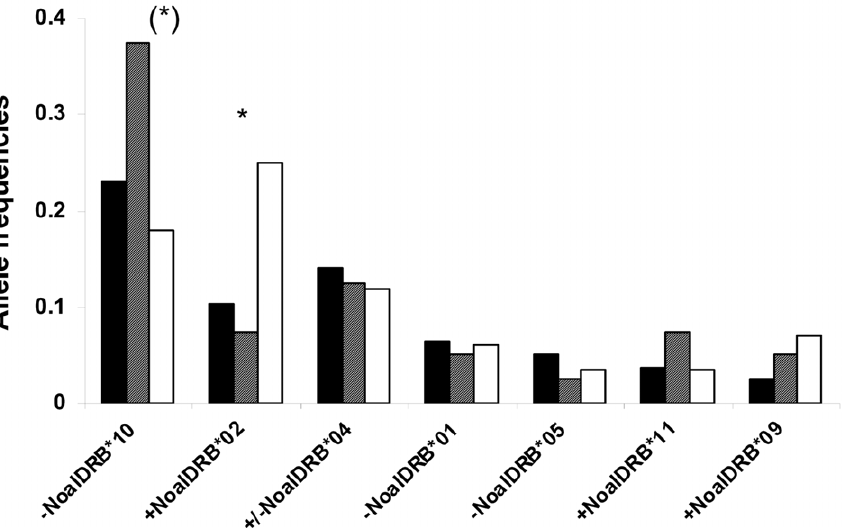
Figure 1. Allele frequencies of MHC class II DRB exon 2 influencing the ectoparasite infestation in N.albiventris . Distribution of Noal- DRB alleles influencing the ticks and bat flies infestation in reproductive males (black bars), subadults (grey bars) and non-reproductive males (white bars). ‘ + ’ indicates an association with an increased and ‘ 2 ’ with a decreased parasite load. Allele Noal-DRB *02 is significant accumulated in non- reproductive males and less frequent in subadults ( x 2 =10.07, p=0.006, df=2, Bonferroni significant, power (1- b err prob) 100%). Contrarily, allele Noal-DRB *10 is less frequent in non-reproductive males and accumulated in subadults ( x 2 =3.20, df=1, p=0.064, power 98%).